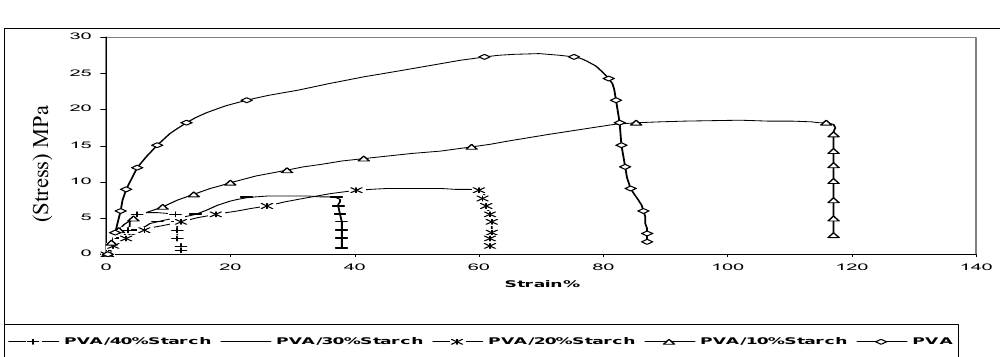
Fig. 5: The stress strain curves of PVA ,and Starch/PVA at different ratio.